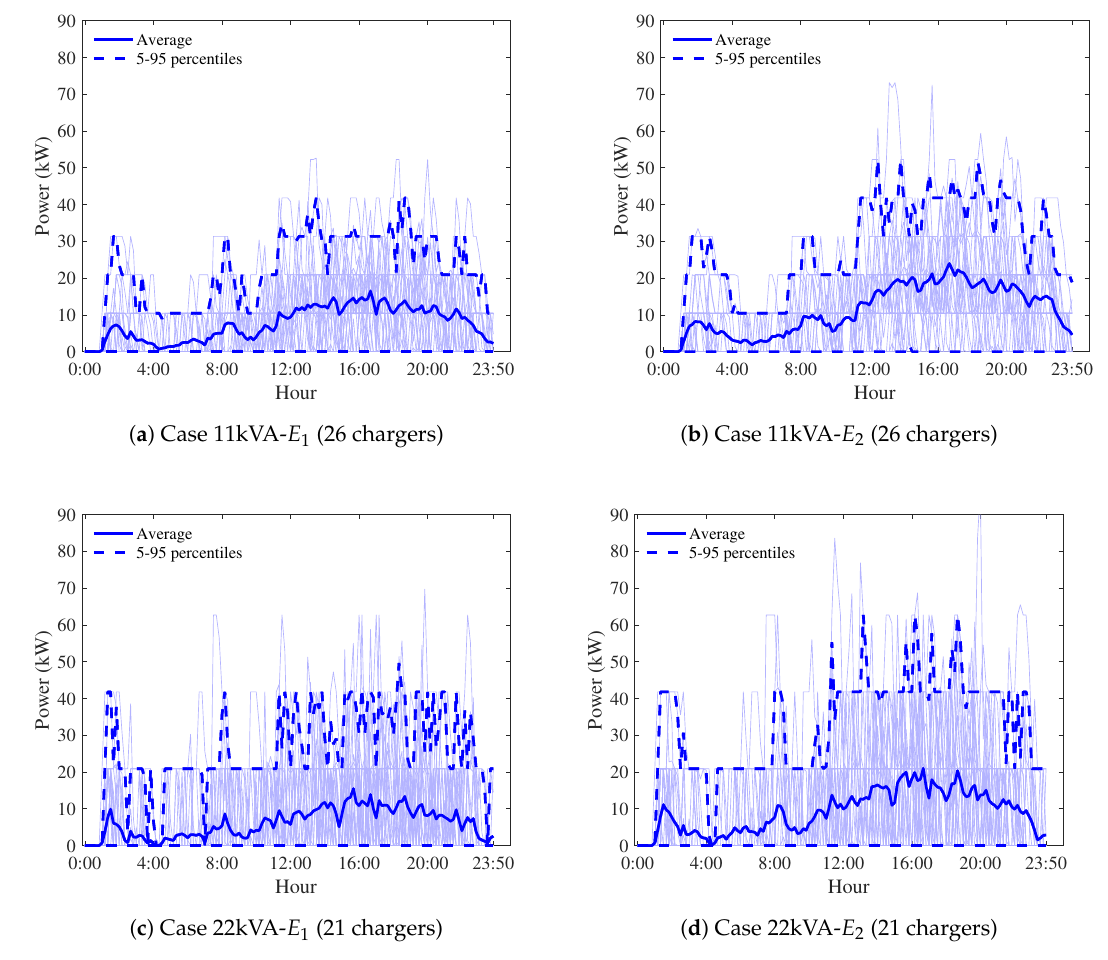
Figure 9. Case study: aggregated charging